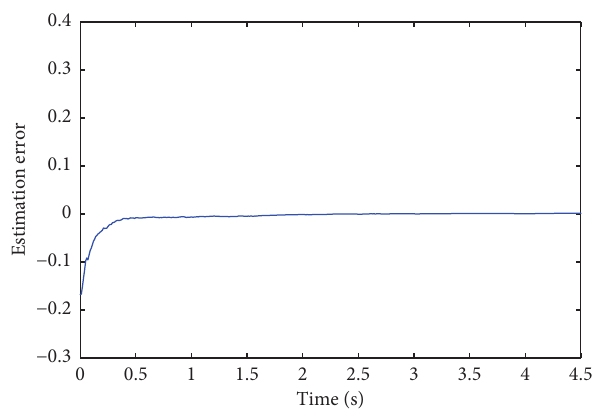
Figure 7: Comparative control performances of joint2 between the proposed method and